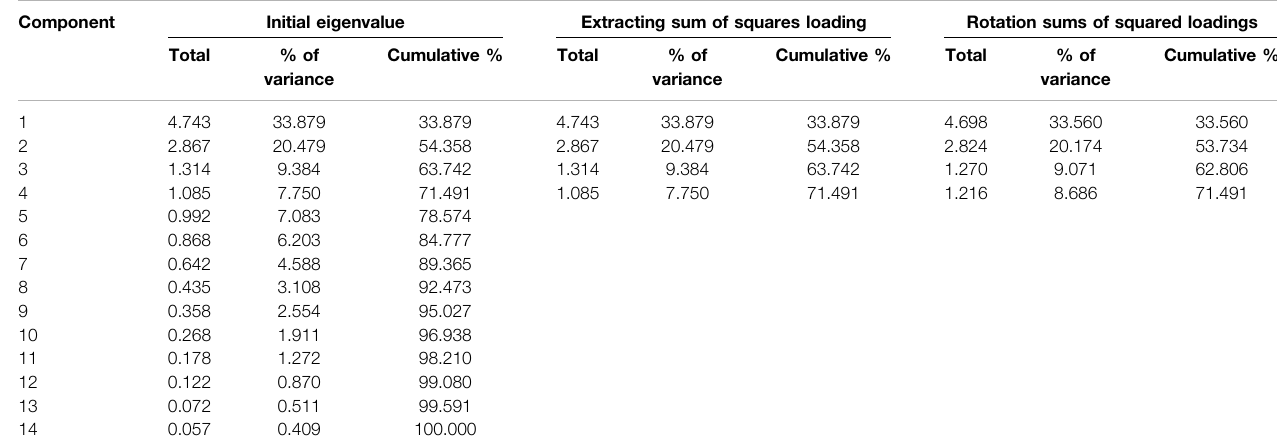
TABLE 3 | Total variance